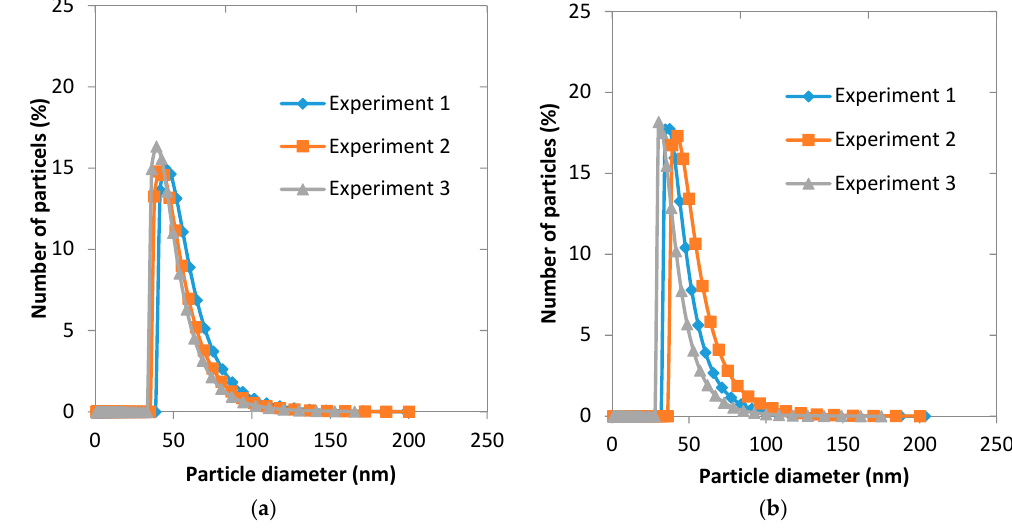
Figure 12. Reproducibility of experiments: ( a ) co-flow glass capillary microfluidic device; and ( b ) membrane device.